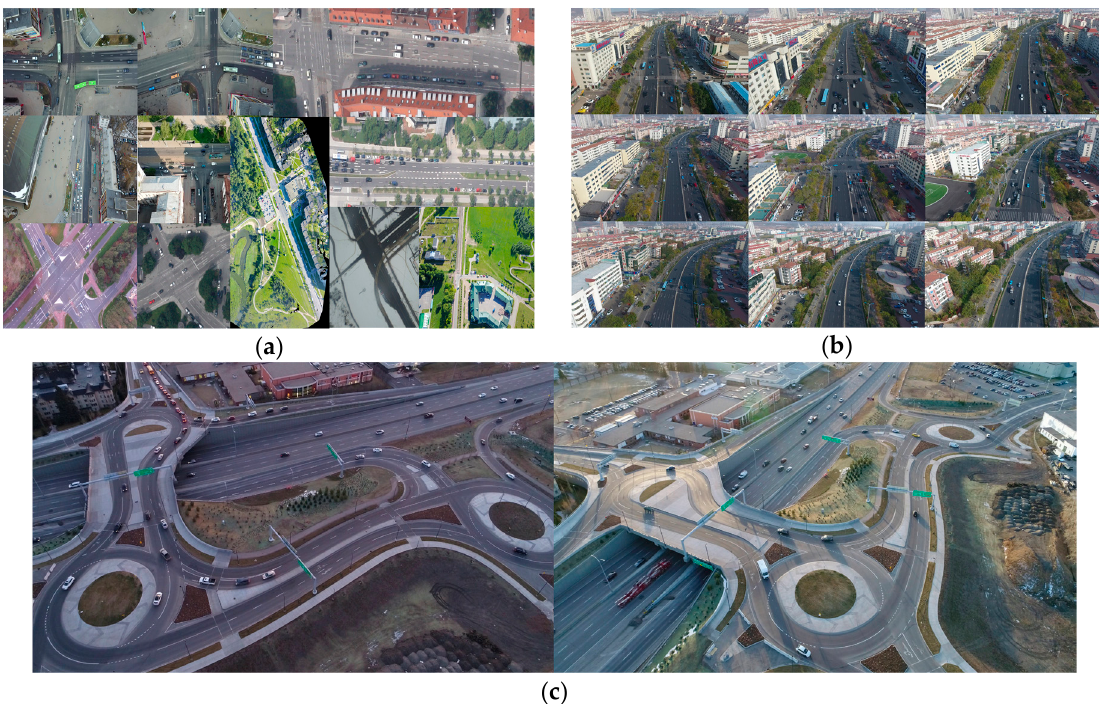
Figure 4. Datasets used for fine-tuning YOLOv3 vehicle detector: ( a ) 155 images from aerial-cars-dataset; ( b ) 1374 images from the UAVDT-Benchmark (M0606); ( c ) 157 images from our UAV videos (DJI_0004 and DJI_0016).